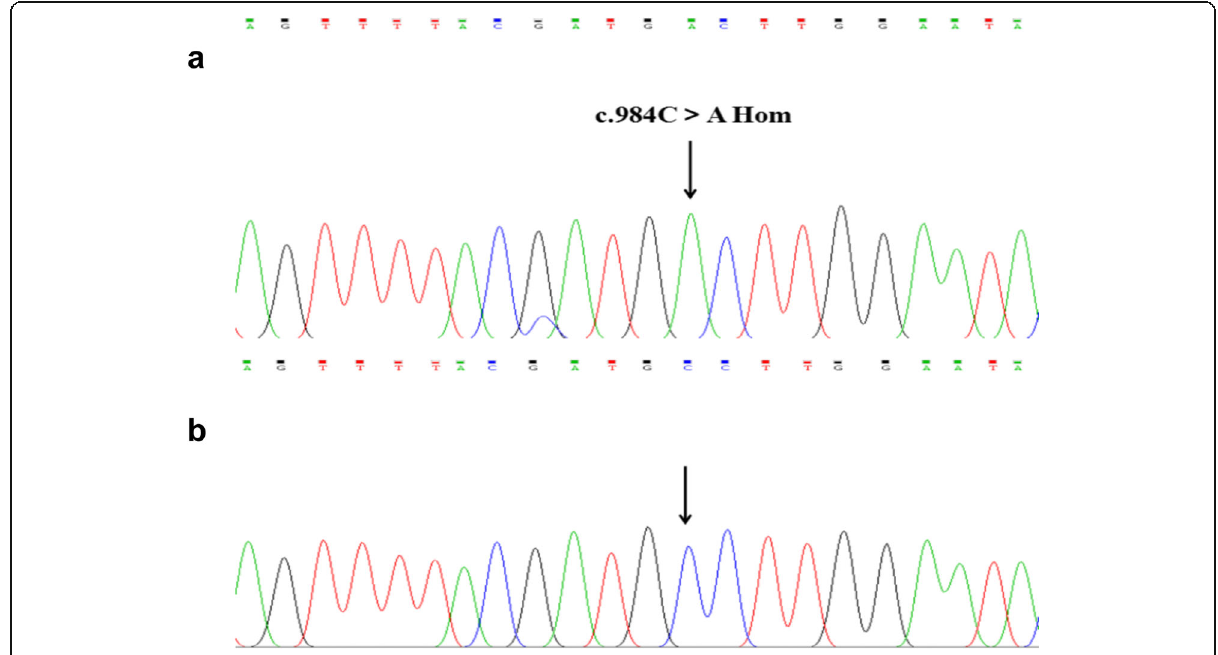
Fig. 1 Identification of the mutation in F13A1 by DNA sequencing. c.984C > A was found in the patient ( a ); the GenBank sequence of F13A1 ( b